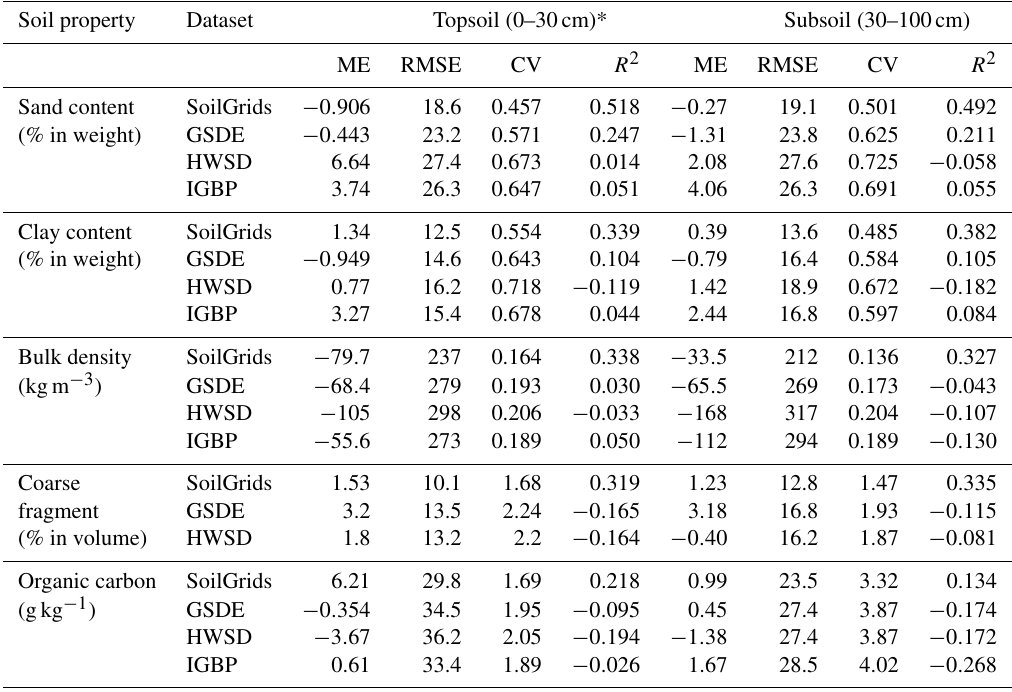
Table 4. Evaluation statistics of soil datasets using soil profiles from the World Soil Information Service (WoSIS). Soil